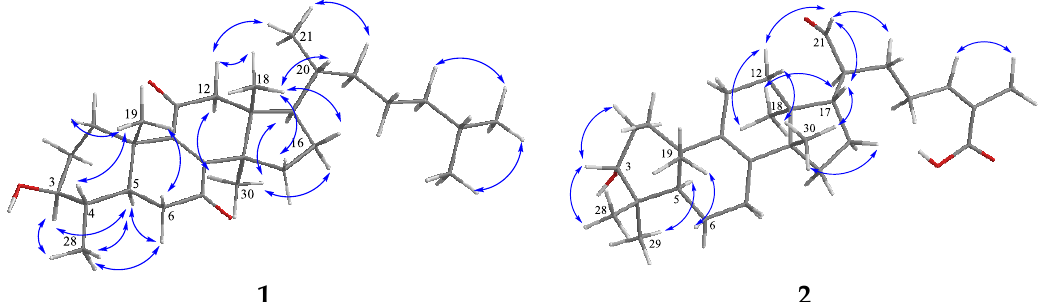
Figure 3. Key NOESY (H ↔ H) correlations of compounds 1 and 2 .